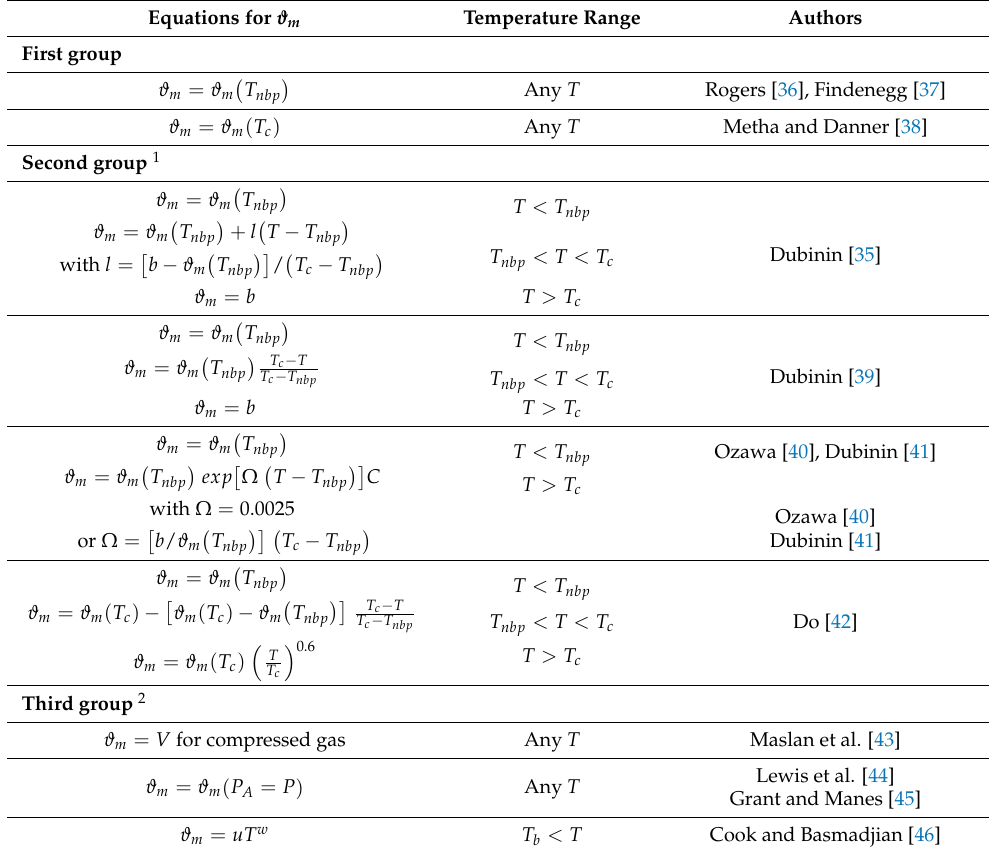
Table 4. Different models for the calculation of the adsorbate molar